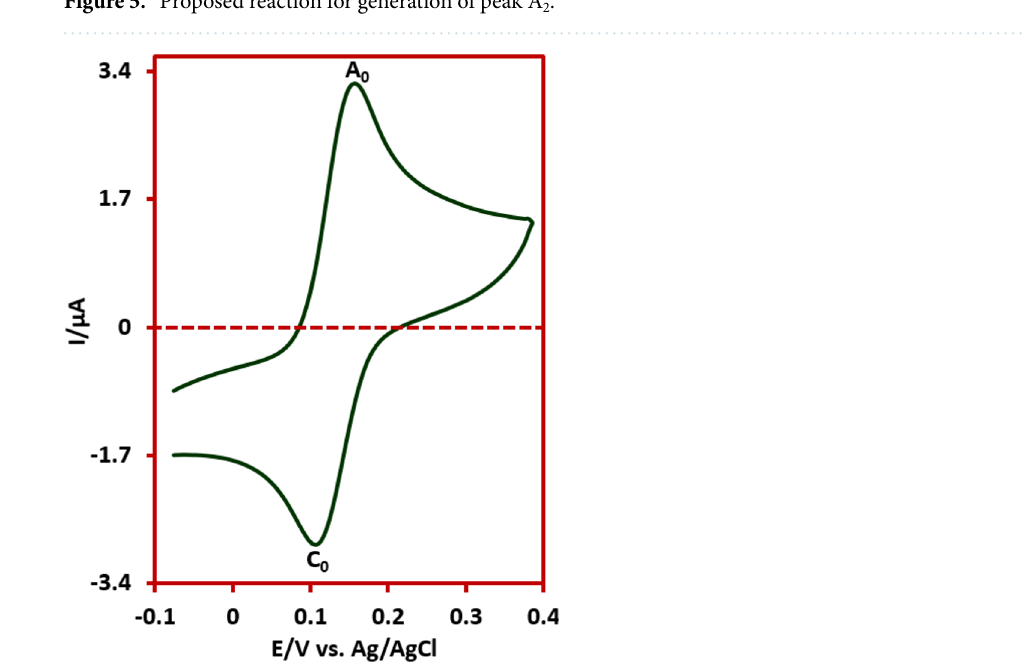
Figure 5. Proposed reaction for generation of peak A 2 .